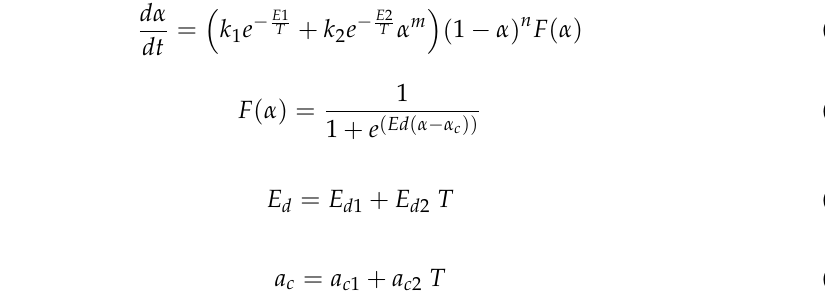
Darcy’s law (Equation (3)).